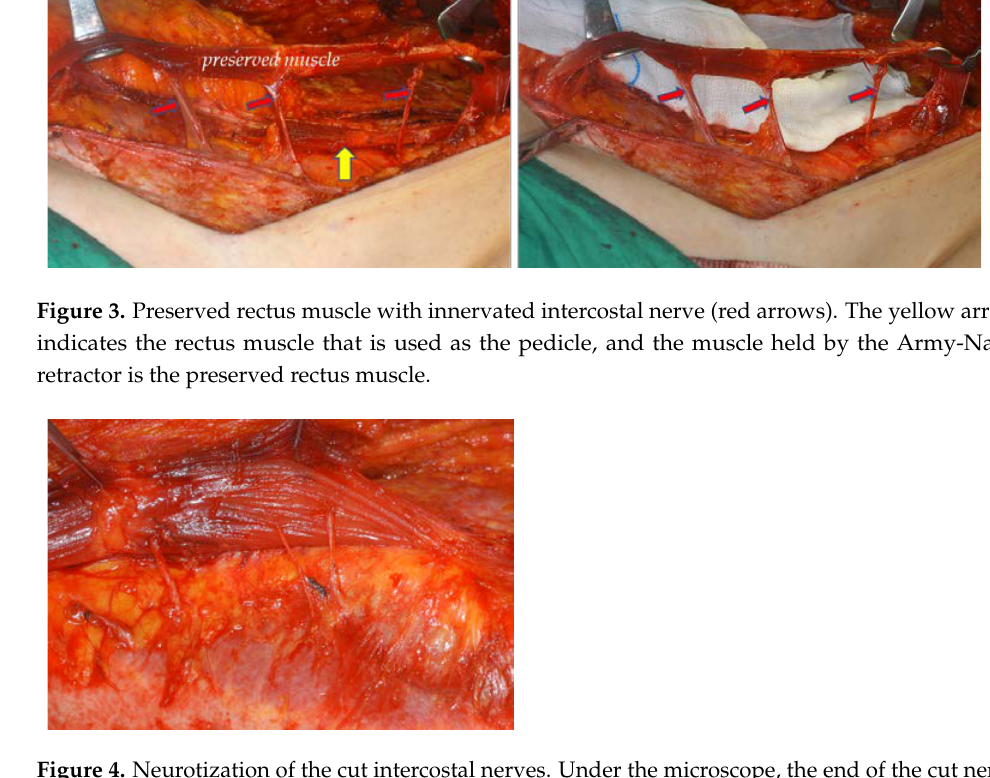
Figure 4. Neurotization of the cut intercostal nerves. Under the microscope, the end of the cut nerve was inserted between the rectus muscle fibers that were open, and the epineurium of the nerve and the epimysium of the muscle were sutured.